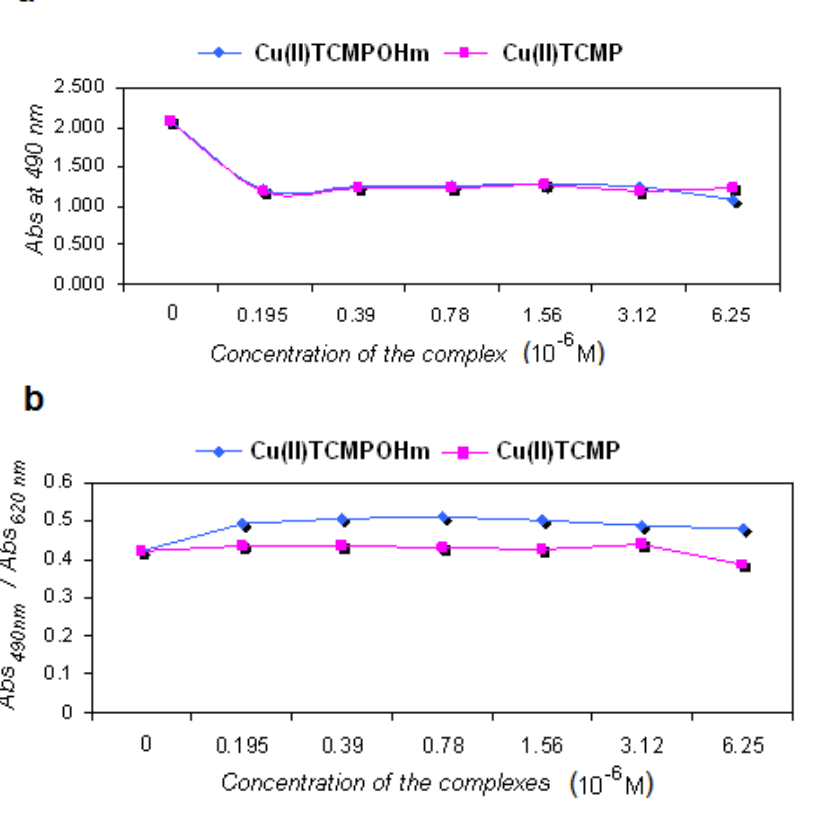
Figure 5. Cellular response of B16 line after 2 h incubation with Cu(II)TCMPOH Cu(II)TCMP ( a – viability, b –